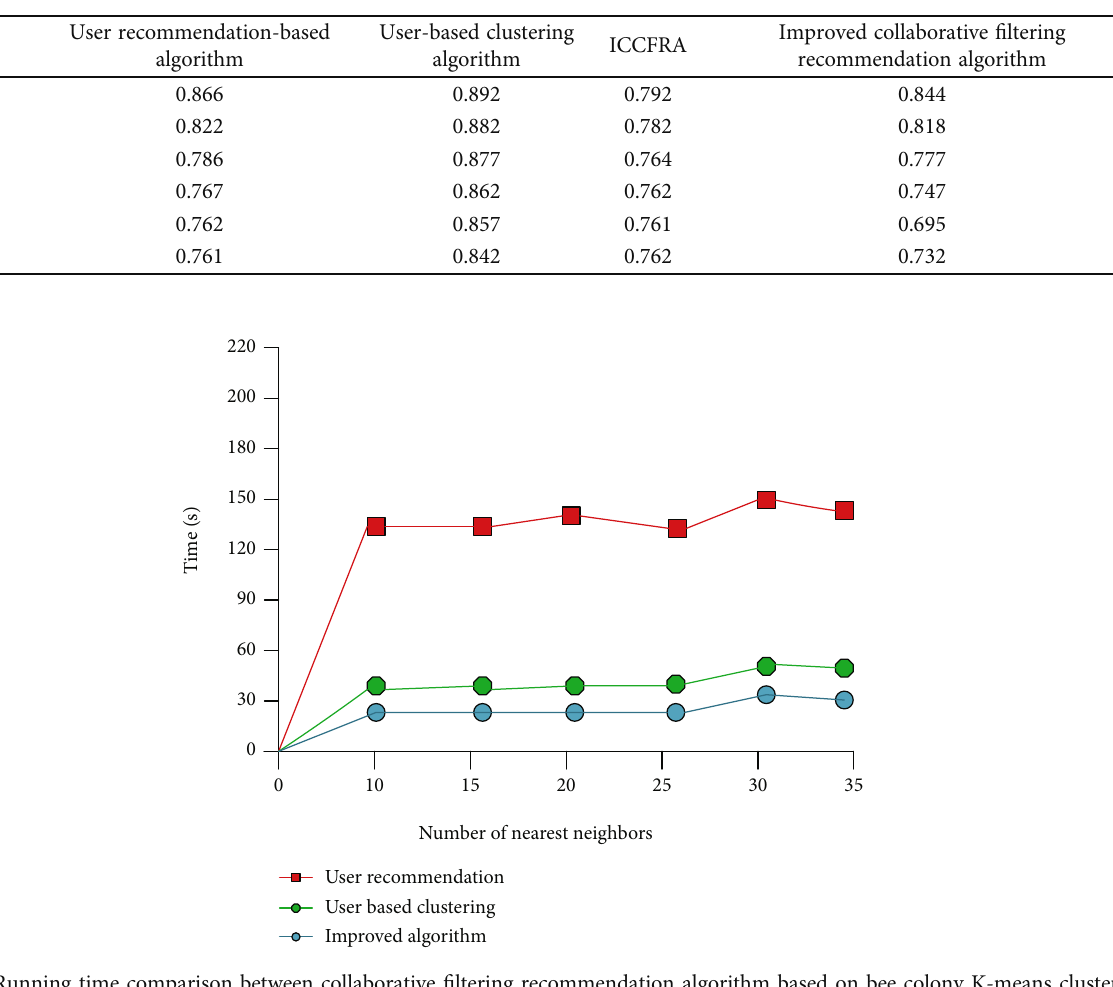
Figure 7: Running time comparison between collaborative fi ltering recommendation algorithm based on bee colony K-means clustering and other algorithms.